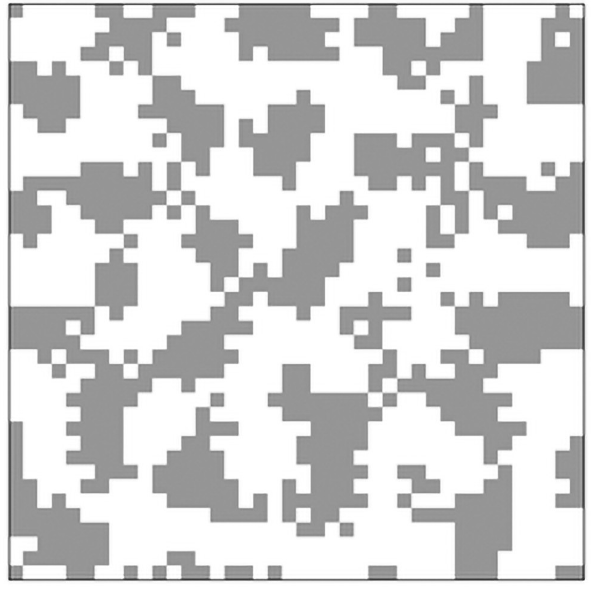
Fig 14. Example of pattern emergence using a modified skin pattern model (calculation results under the conditions of s = 5.0, w = 0.225).